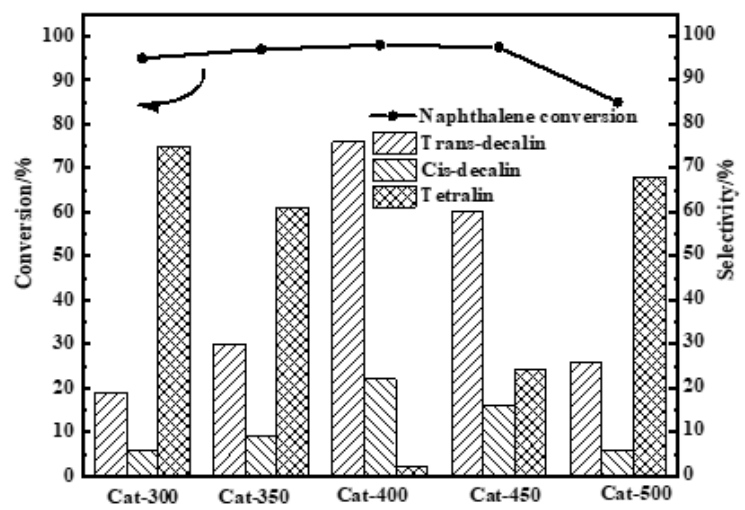
Figure 5. Catalytic activity of different Ni 2 P/Al 2 O 3 catalysts.